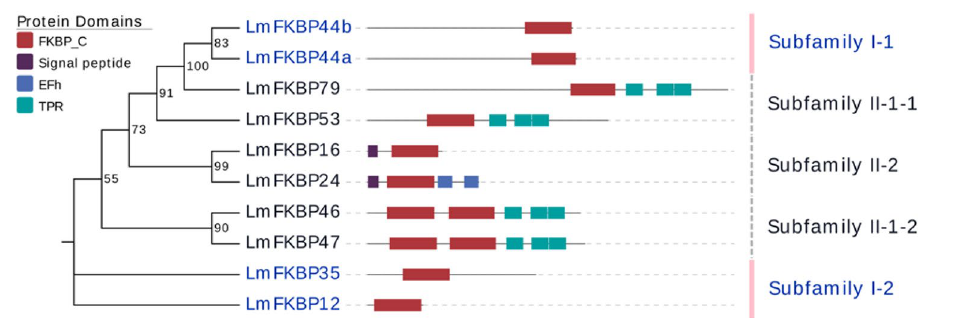
Figure 2. Multiple sequences alignment of FKBP_C domains. Drosophila melanogaster (Dm); Locusta migratoria (Lm). The ClustaIW program in MEGA7 software was used for multiple sequence alignment, and the GeneDoc software was used for mapping. The shaded part indicates conserved amino acids.